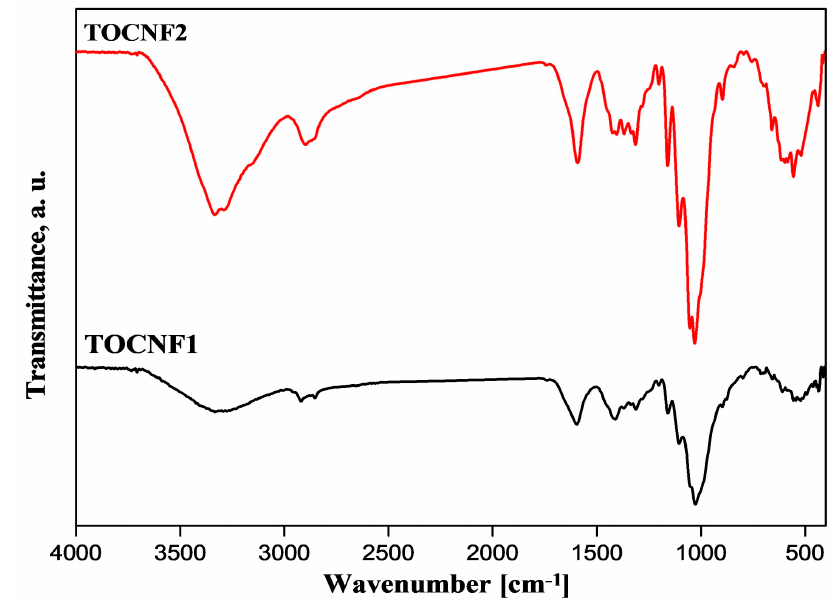
Figure 2. FT-R spectroscopy of TOCNF1 and modified